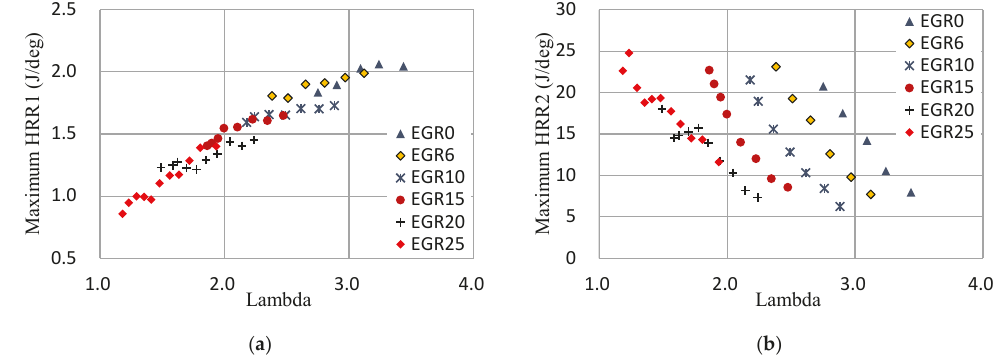
Figure 16. Effects of lambda on maximum heat release rate: ( a ) First stage combustion, HRR1; ( b ) Second stage combustion, HRR2.